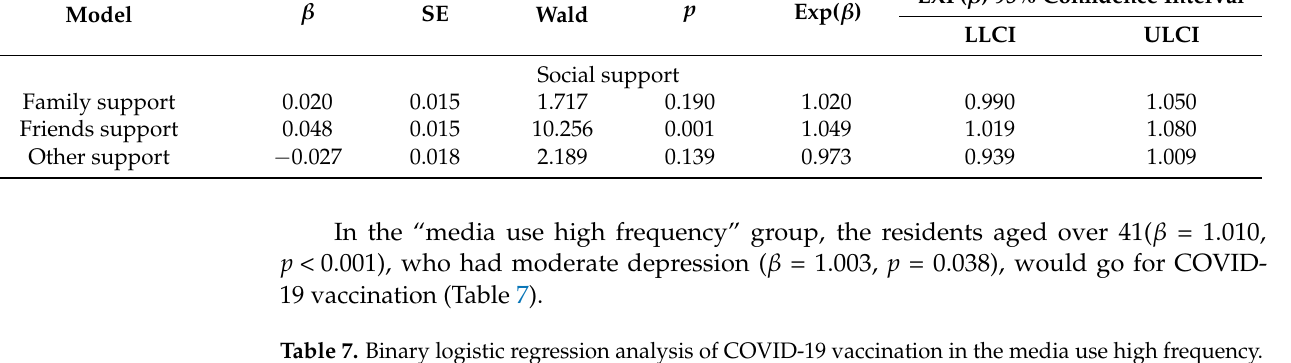
Table 7. Binary logistic regression analysis of COVID-19 vaccination in the media use high